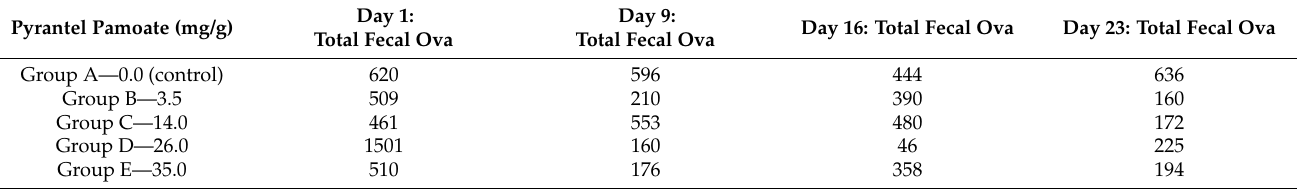
Table 2. Dubia roach group ( n = 24), Blaptica dubia , hindgut examination results of pinworm, Leidynema appendiculata fecal ova count (#/gram feces) at Days 1, 9, 16 and 23 after oral pyrantel pamoate anthelmintic treatment via medicated or control gel